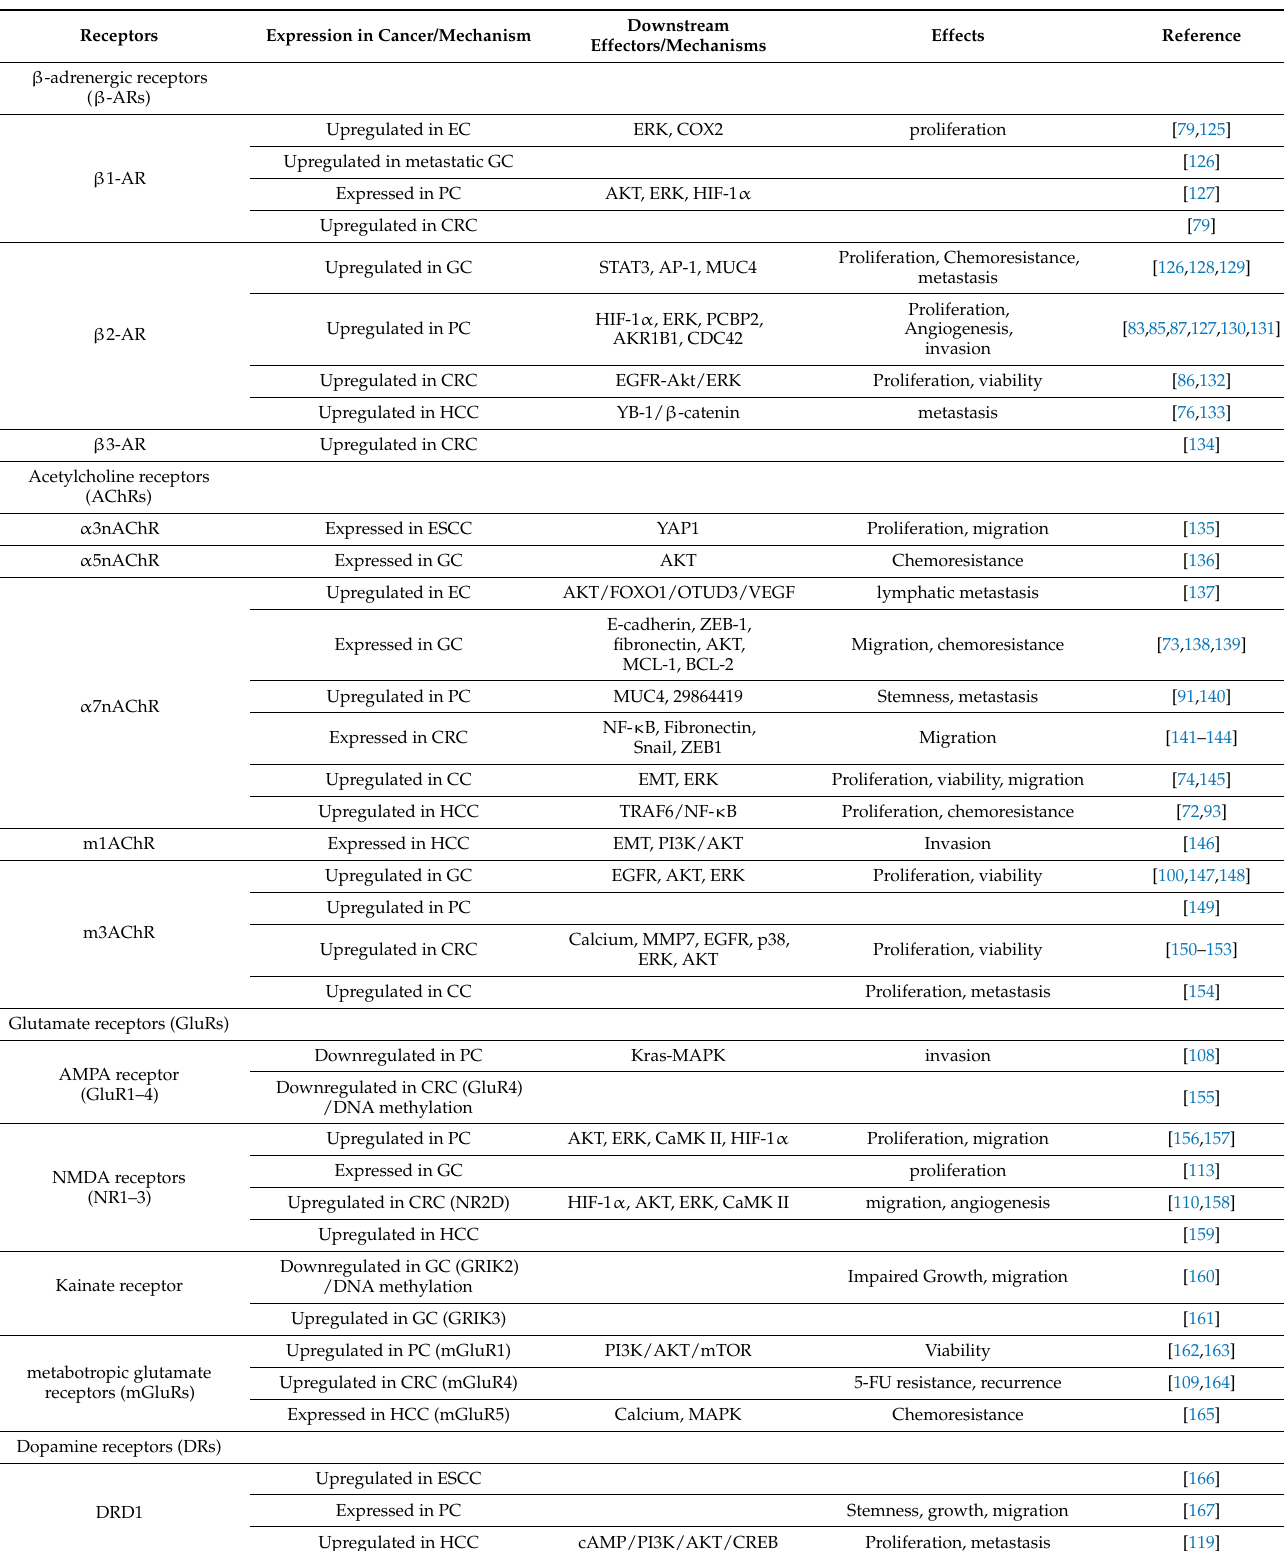
Table 1. The expression and roles of neurotransmitter receptors in gastrointestinal